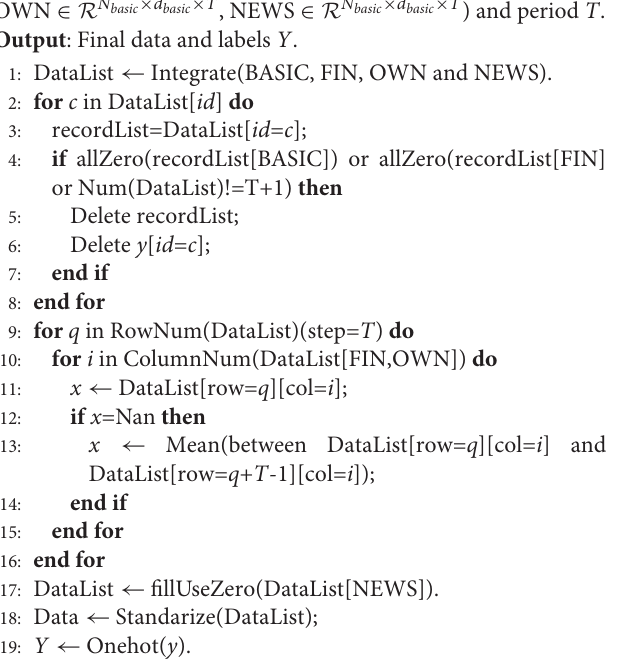
Algorithm 1 DataPre